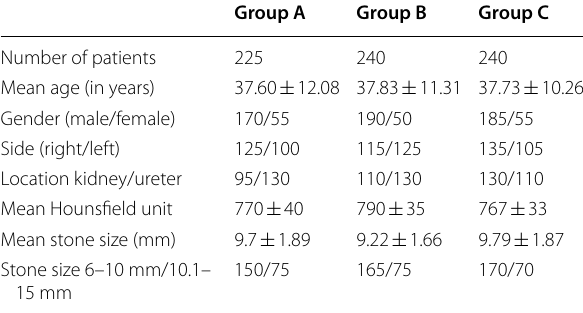
Table 1 Demographic data of patients